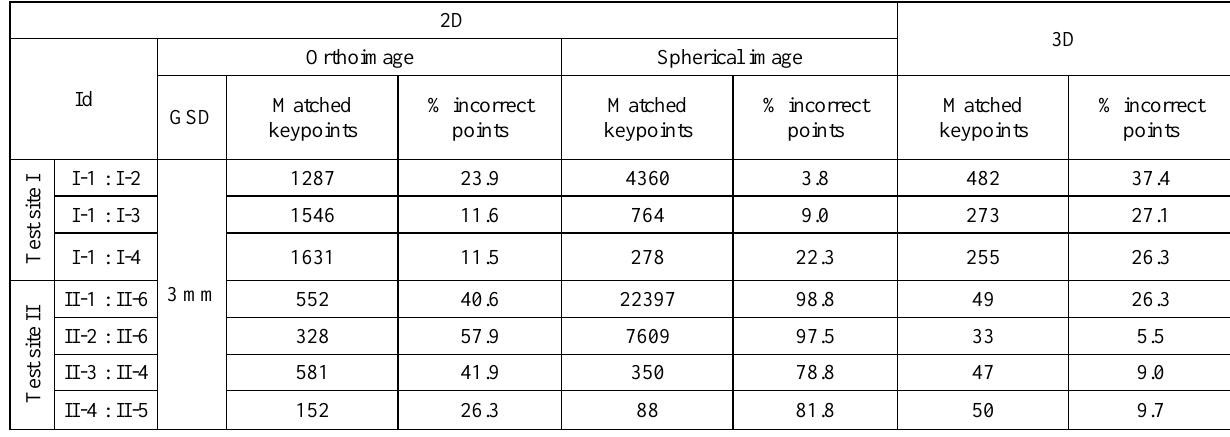
Table 1. The percentage of the correctly detected and matched keypoints